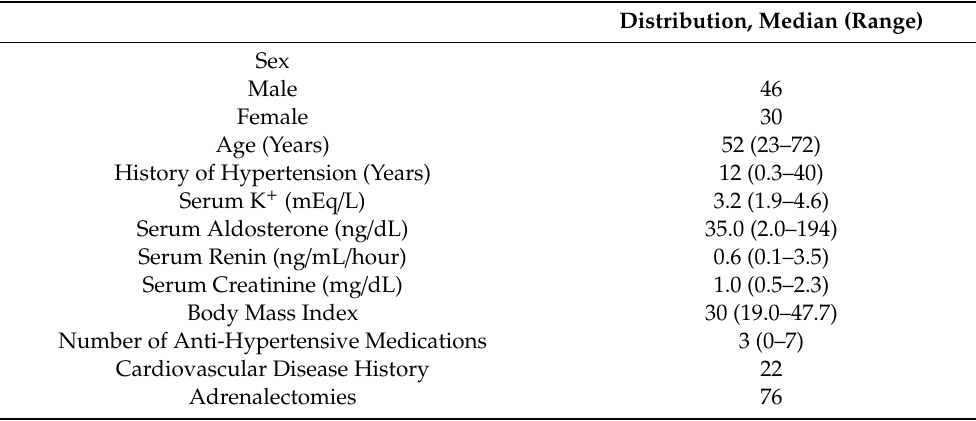
Table 1. Demographic and clinical characteristics of the study